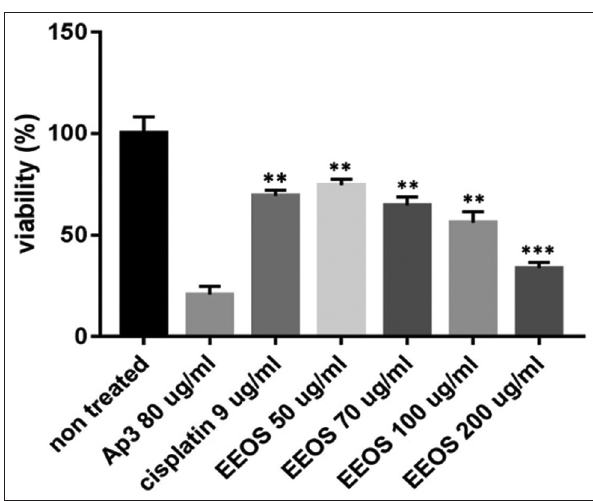
Figure-12: The inhibitory and antiproliferative effect of the ethanolic extract from Ocimum sanctum Linn. (EEOS) against non-small cell lung cancer (A549) cells. The cells were cultivated in the presence of an inhibitor (AP3) as the positive control, cisplatin as the commercial drug comparison, and EEOS at concentrations of 50, 70, 100, and 200 µ g/mL. After 24 h, EEOS’s inhibitory effect was visualized by an MTT reagent at a wavelength of 595 nm (NT: Non-treated; ** significant p<0.0072; ***significant p<0.0002; n.s.=Not